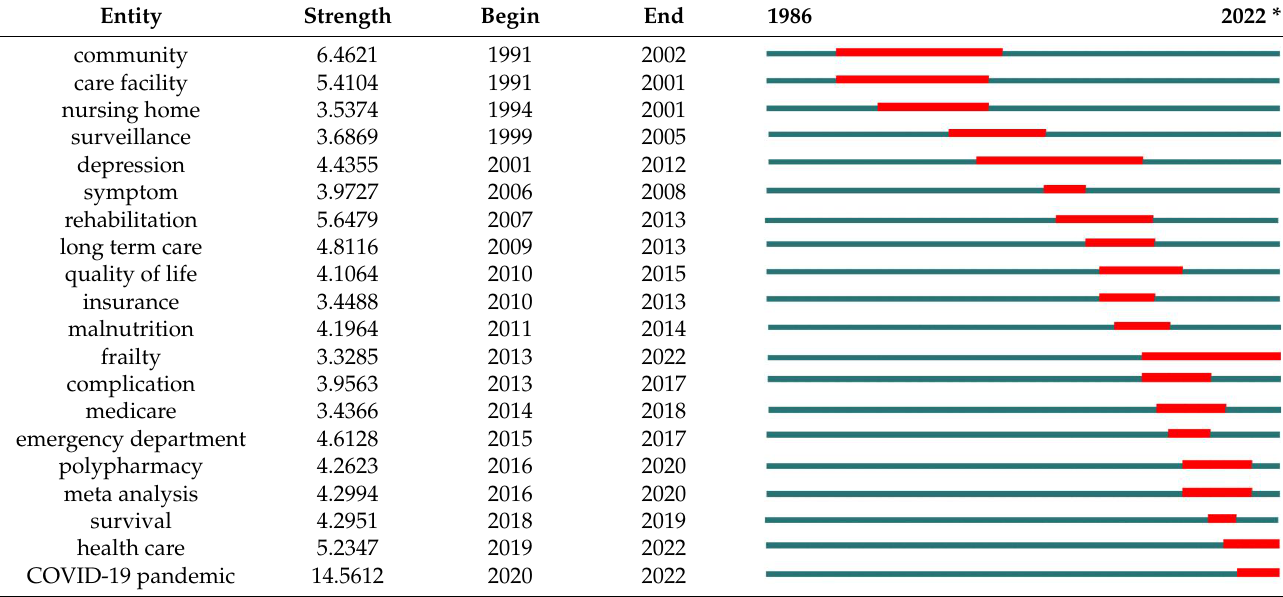
Table 5. Top 20 burst keywords for FCMNCE research, 1986 –